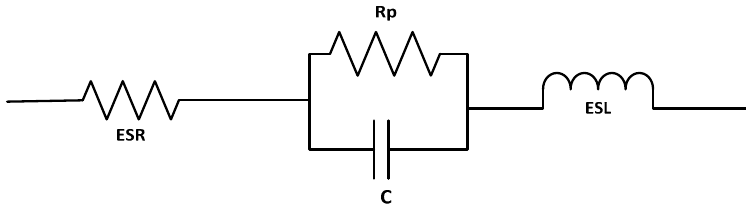
Figure 3. SC simplified circuit model [24].